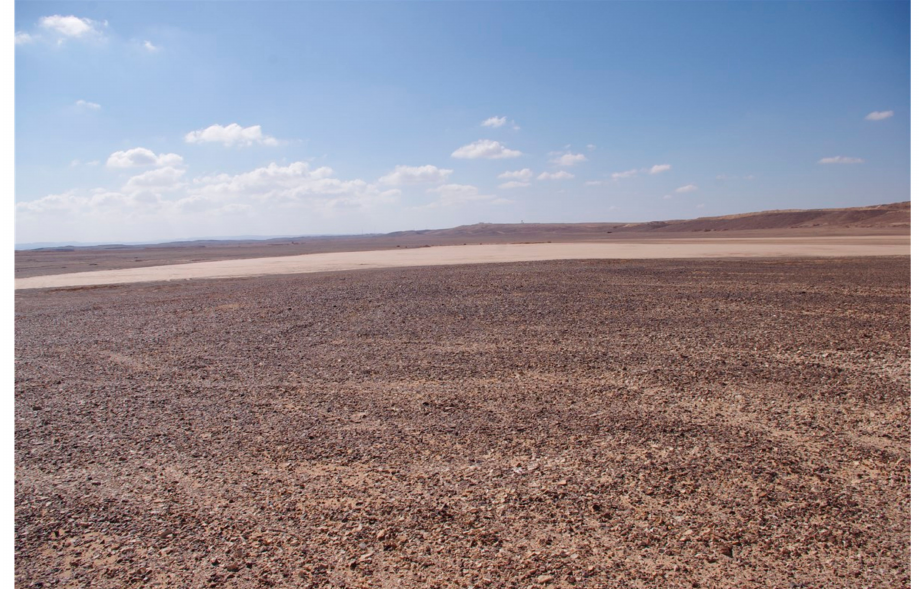
Figure 5. Avraham Playa (Qa Avraham), a southward sight. Notice the playa’s terminal bottom. Picture taken by Ilan